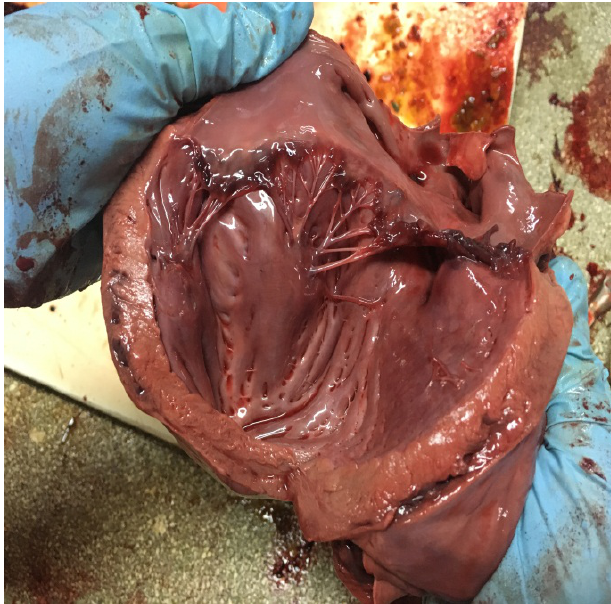
Fig. 2. Heart muscle is light red in color, with a faint texture According to histological examination of the muscular tissue of the heart of dogs that died within 10–12 hours after poisoning, it was observed a significant disorders of hemo- circulation, which were diffuse and manifested in full- blooded, diapedous hemorrhages. The lesions of the vessels of the microcirculatory bed were combined with the phe- nomena of paresis, capillary stasis. In the lumen of the capil- laries, the uniform elements of the blood were poorly visual- ized as a result of their destruction. The lumen of the venous vessels is sharply expanded, filled with shaped elements of blood. In sharply expanded veins and venules, the structure of the inner elastic membrane is disturbed (Fig. 3).